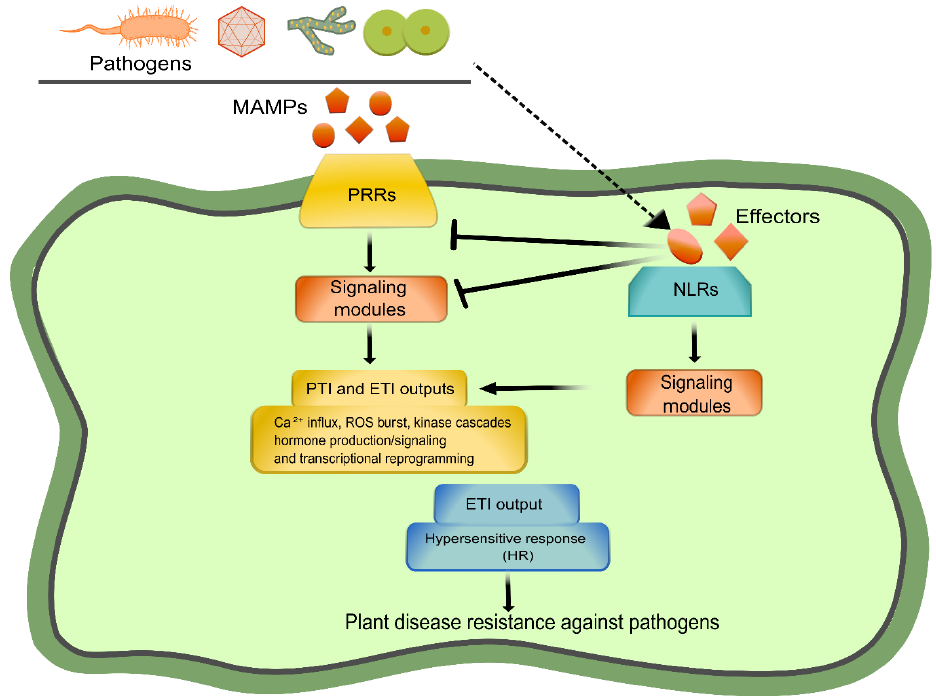
Figure 1. Plant immunity branches: PRR-mediated PTI and NLR-mediated ETI. A general model depicting the two layers of plant immunity is shown. The activation of both pathways can be divided into three phases: immune perception, signal integration, and defense execution. PRRs and NLRs are involved in the first phase, recognizing pathogen-derived molecules. Then, the signal is transduced and integrated through a network of components (signaling modules), deriving in downstream outputs (ROS burst, hormone production/signaling, transcriptional reprogramming, and cell death) aimed at restricting pathogen invasion. Created with Inkscape (https://inkscape.org) and GIMP v2.10.24 (https://www.gimp.org).